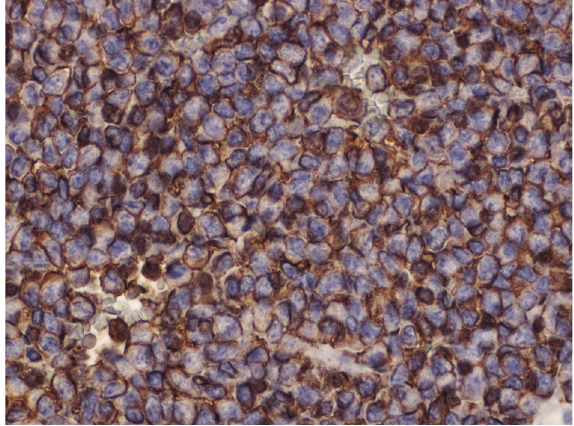
Figure 2: Crisp membrane staining with CD99.